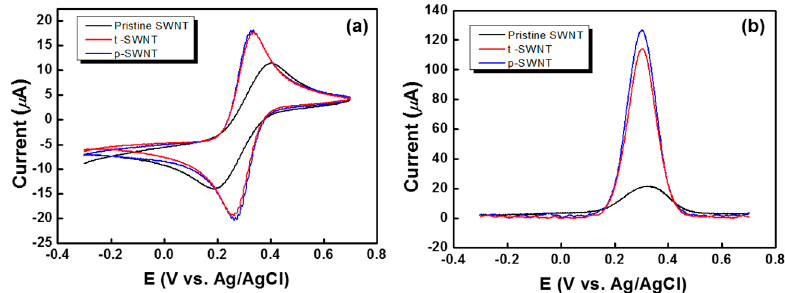
Figure 7. Electrochemical properties of the modified electrodes in a 3 M KCl solution containing 10 mM K 3 [Fe(CN) 6 ] at 100 mV · s − 1 : ( a ) cyclic voltammograms and ( b ) square-wave voltammograms. Note that the p-SWNT shows the smallest peak potential separation and the biggest i p . This indicates the best surface condition of the p-SWNT electrode. Note that the modified electrodes are prepared under optimal treatment conditions. Table 3. Sensing performances of the modified SWNTs.